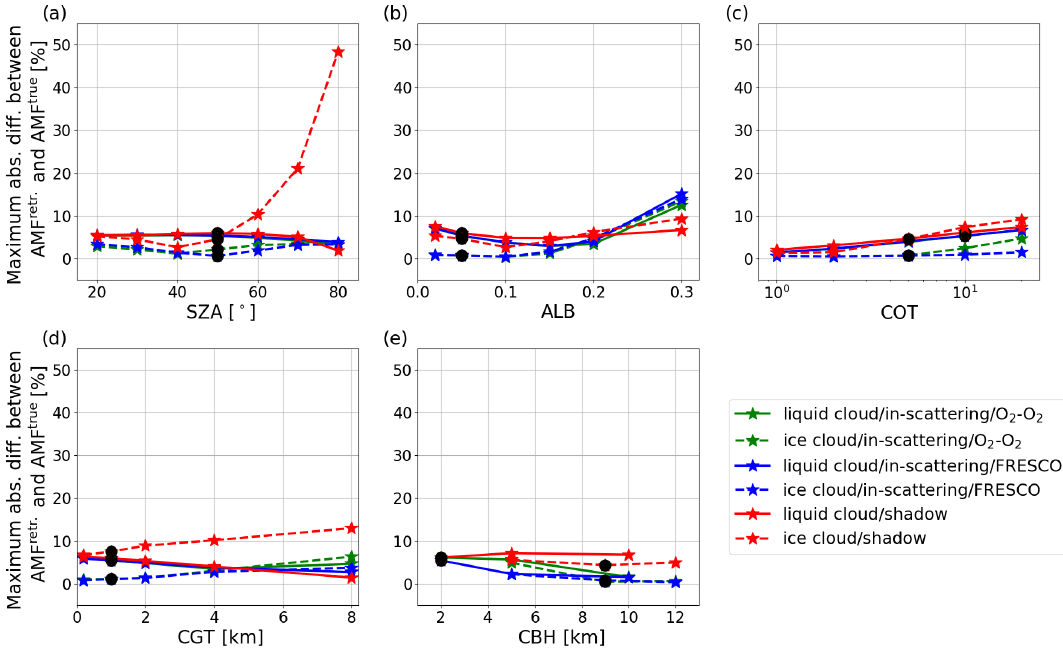
Figure A3. Similar to Fig. 4 but the AMF retrieval using the clean NO 2 profile.